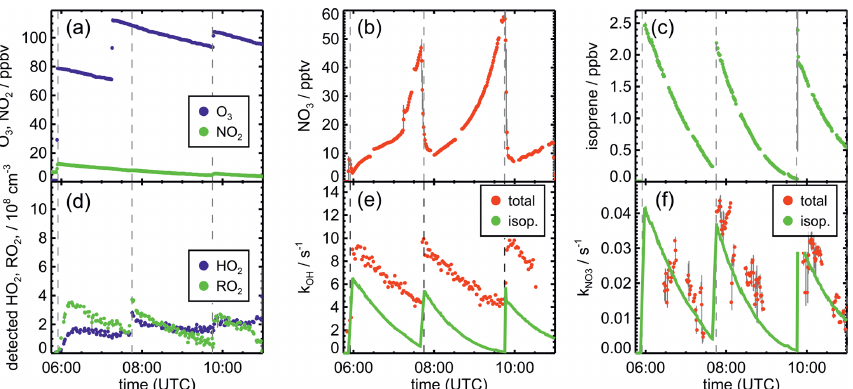
Figure A2. Measurements of radical and trace gas concentrations and OH and NO 3 reactivity in the experiment on 12 August 2018 (Exper- iment 3) investigating the oxidation of isoprene by NO 3 . NO 3 reactivity does not include reactivity from organic radicals and NO 2 . OH and NO 3 reactivity from isoprene is calculated from measured isoprene concentrations and reaction rate constants recommended in the literature (Mellouki et al., 2021). Observed RO 2 radicals only include a fraction of the total RO 2 because the LIF instrument cannot detect all RO 2 radicals formed in the reaction of isoprene with NO 3 (Vereecken et al.,